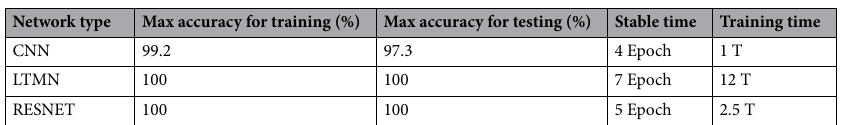
Table 4. Actuator fault type